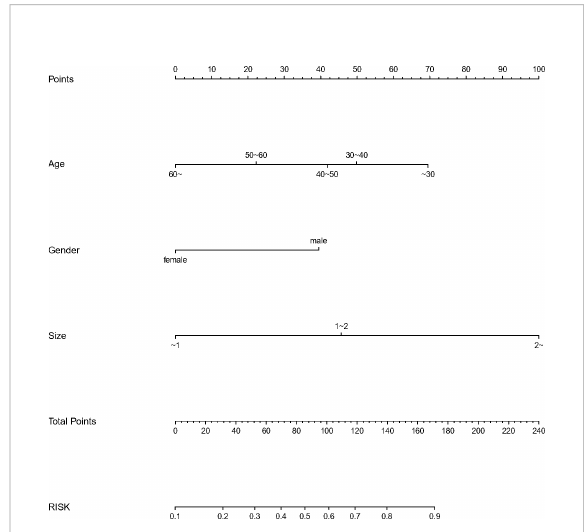
FIGURE 3 Nomogram to predict the risk of ipsilateral (CLNM)for patients with (IPTC). CLNM, central lymph node metastasis; IPTC, isthmic papillary thyroid carcinoma.